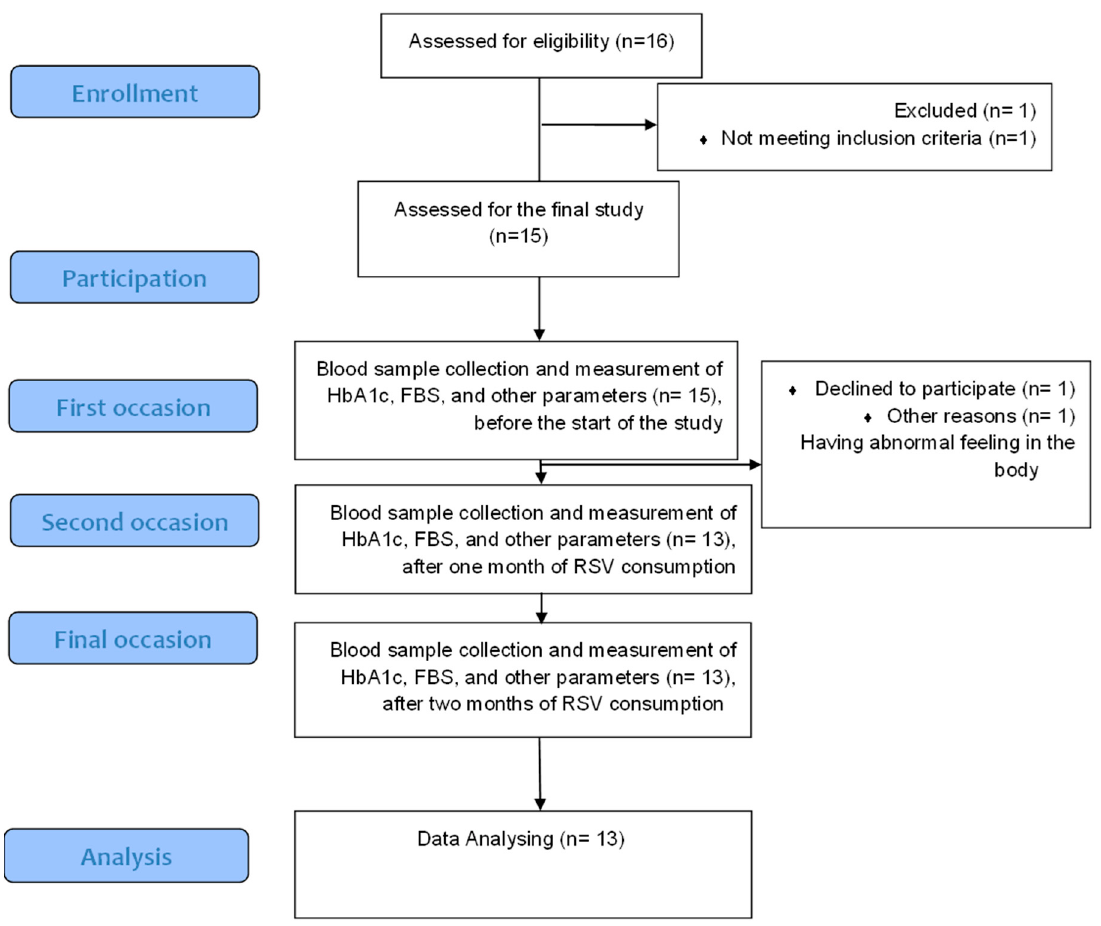
Figure 1. Consort flow diagram of the study.